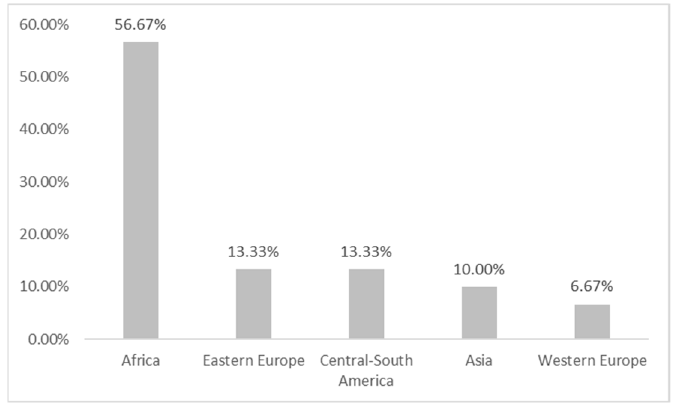
Figure 3. Distribution of foreign minors according to the country of origin.